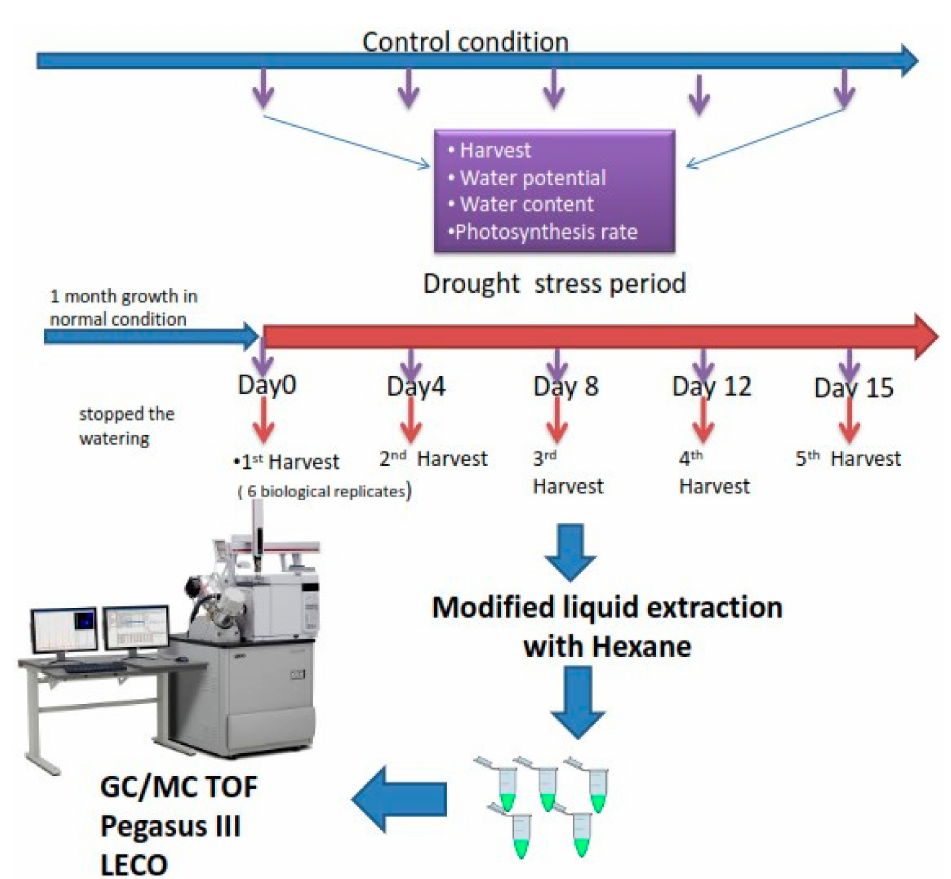
Figure 7. Experimental design to explore the volatile composition alterations over drought stress period using combined physiological and non-targeted volatilome